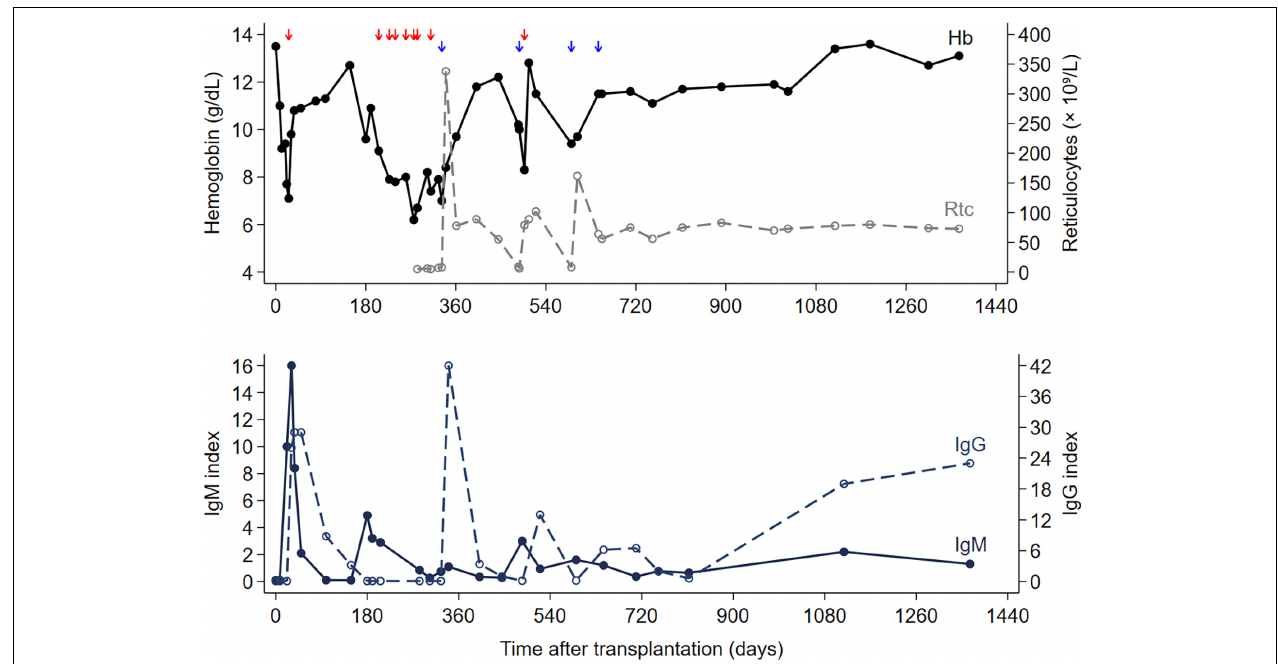
FIGURE 1 | Hemoglobin level, reticulocyte count, IgM and IgG indexes, and time of blood transfusions (red arrow), and IVIg therapy (blue arrow) after